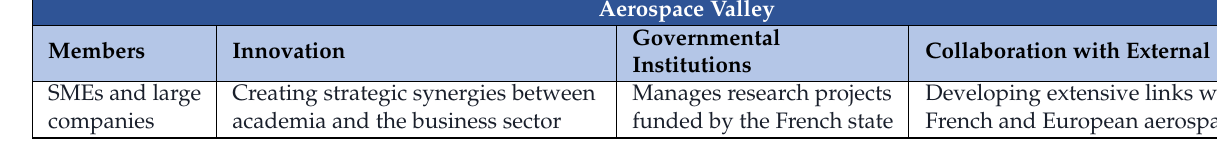
Table 2. Main characteristics of the Aerospace Valley, according to Markusen’s typology. Aerospace